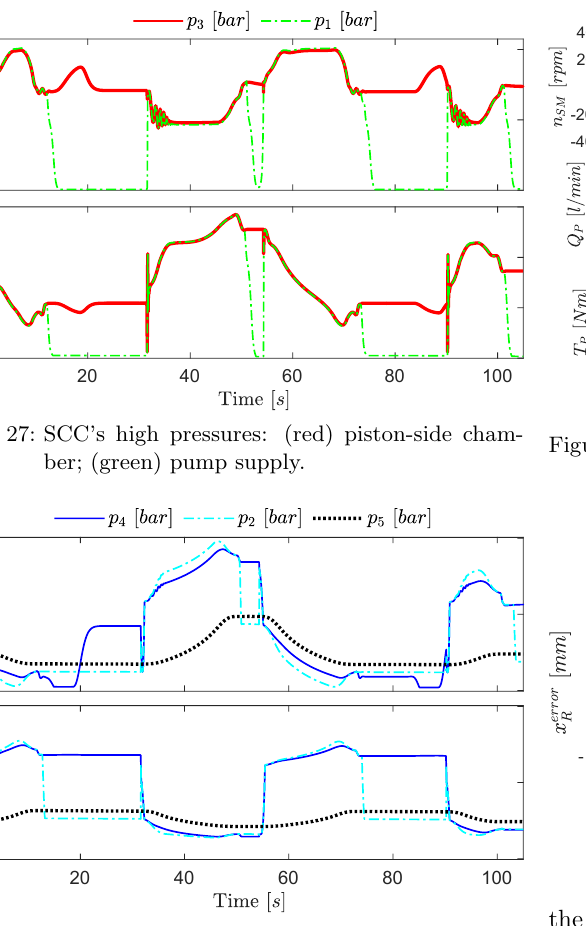
Figure 28: SCC’s low pressures: (blue) rod-side chamber; (light blue) pump’s suction-side; (black) accu- mulator.